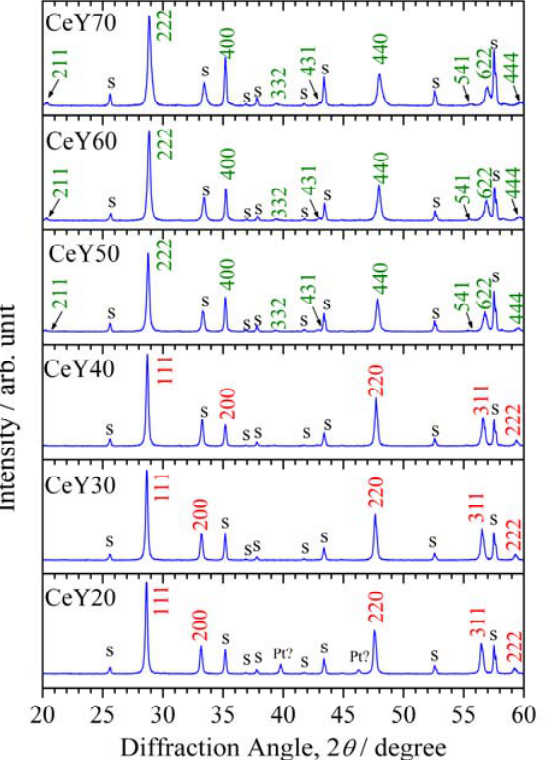
Figure 2. XRD patterns for thick films with various Y concentrations, fired at 1,373 K. “CeY x ” indicates a composition of Ce the